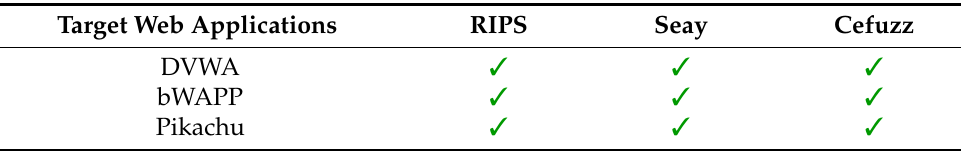
Table 2 . Basic ability evaluation experiment results.